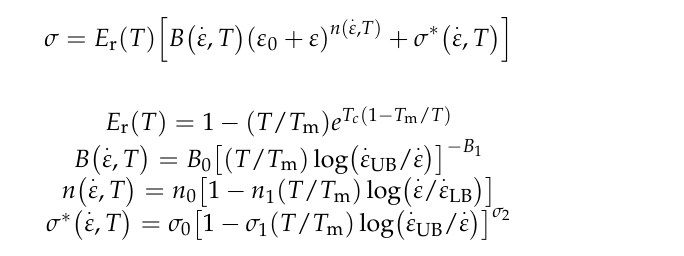
. . ε LB = 10 − 6 s − 1 , ε UB = 10 6 s − 1 , and